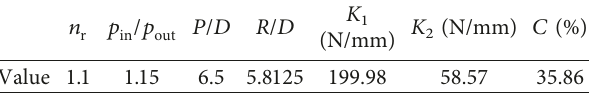
Table 10: The structural parameters and stiffness-damping of the GGQ25-62 WRI. p p P / D n r in / out